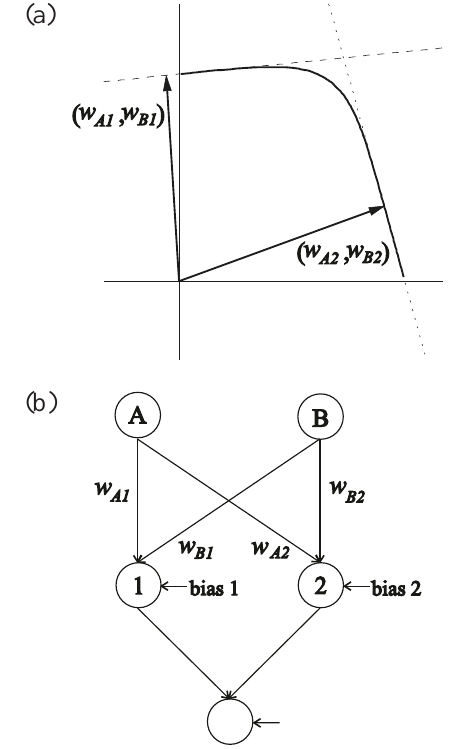
Fig. 7. The decision boundary is shown (a), for a network with two hidden units (b). If we plot the weights leading into the hidden units as vectors in the feature space, we obtain the vectors shown. This shows how each hidden unit behaves as a discriminant function for objects in one area of the feature space. The dotted lines are the discriminant functions determined by the respective vectors and biases shown in